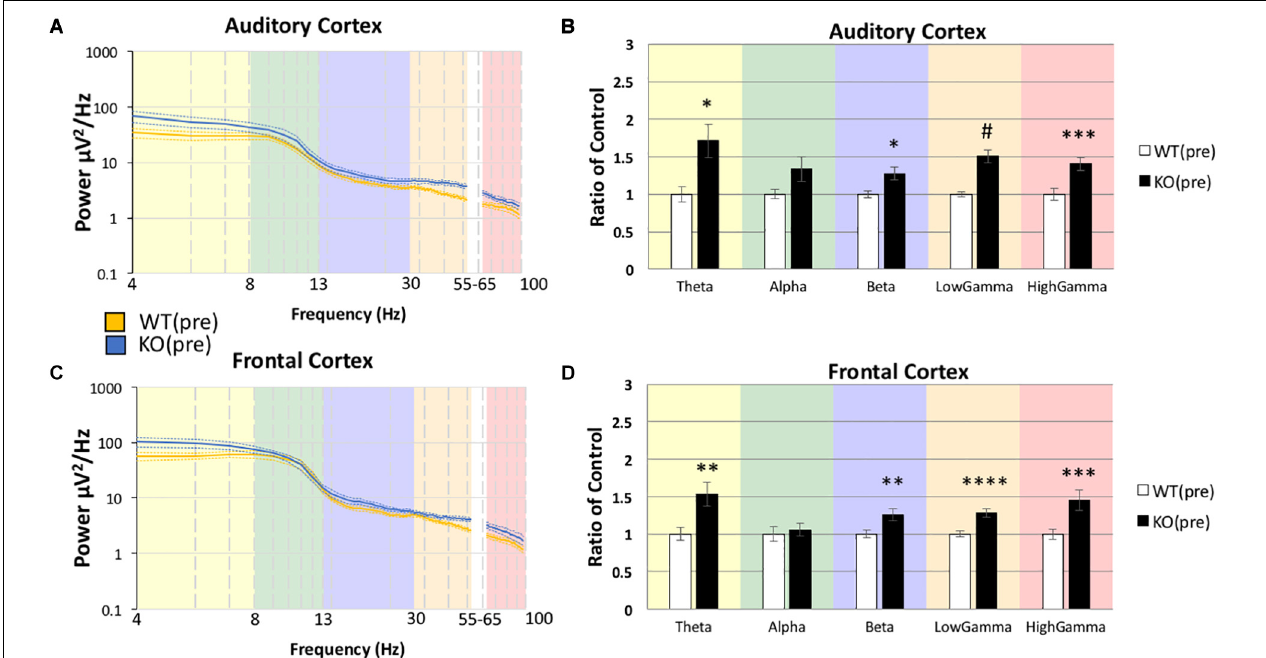
FIGURE 2 | Increased resting power was observed in Fmr1 KO mice compared to WT mice in the pre-drug condition. After mice were habituated to the recording area, 5 min resting EEG was recorded in the absence of any overt sensory stimulation. Mean power density was calculated for both genotypes using both auditory and frontal cortex electrodes (A,C) . For statistical comparisons, average power in each frequency band (color) was compared using standard frequency cutoffs (B, D) . Statistical comparisons are the result of MANCOVA, using the % movement for individual animals as a covariate, in order to isolate genotype effects from potential hyperactivity phenotypes. In general, Fmr1 KO mice showed an increase in raw power, but the most statistically robust differences were in the low and high gamma band ranges. p -values were corrected for multiple comparisons using Bonferroni procedures, and each brain region was run separately (23 Fmr1 KO